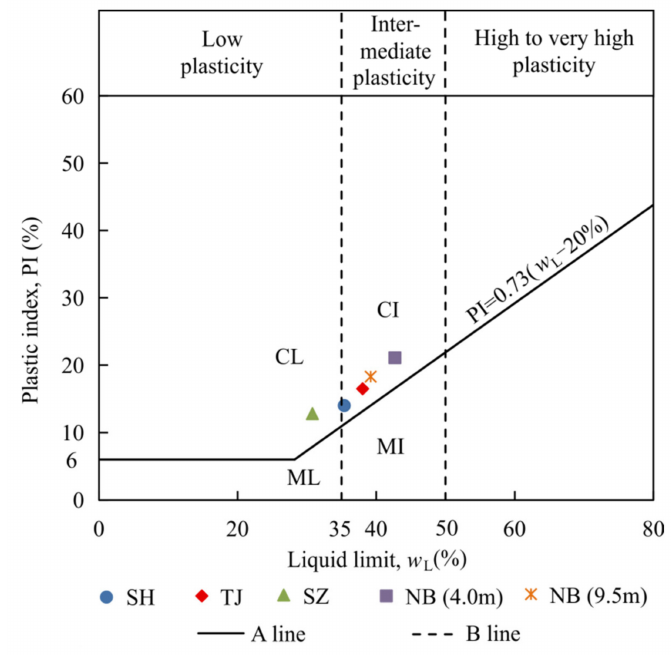
Figure 4. Plasticity